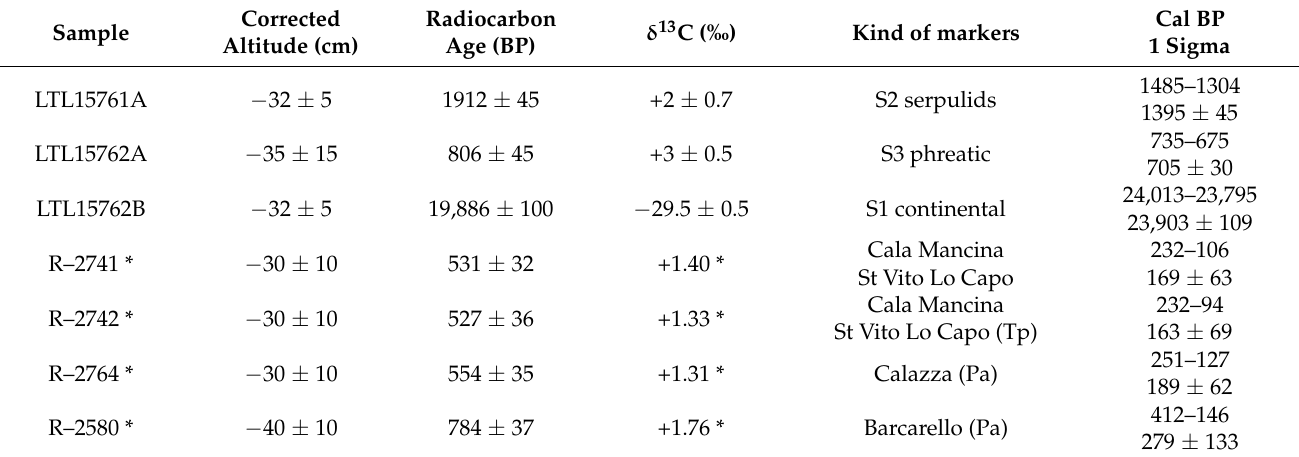
Table 3. Radiocarbon data for Favignana Island stalactite cave. Column 1: * are from [65]. Column 4 * unavailable error bar. The obtained conventional radiocarbon ages were calibrated by using the Calib 8.10 software